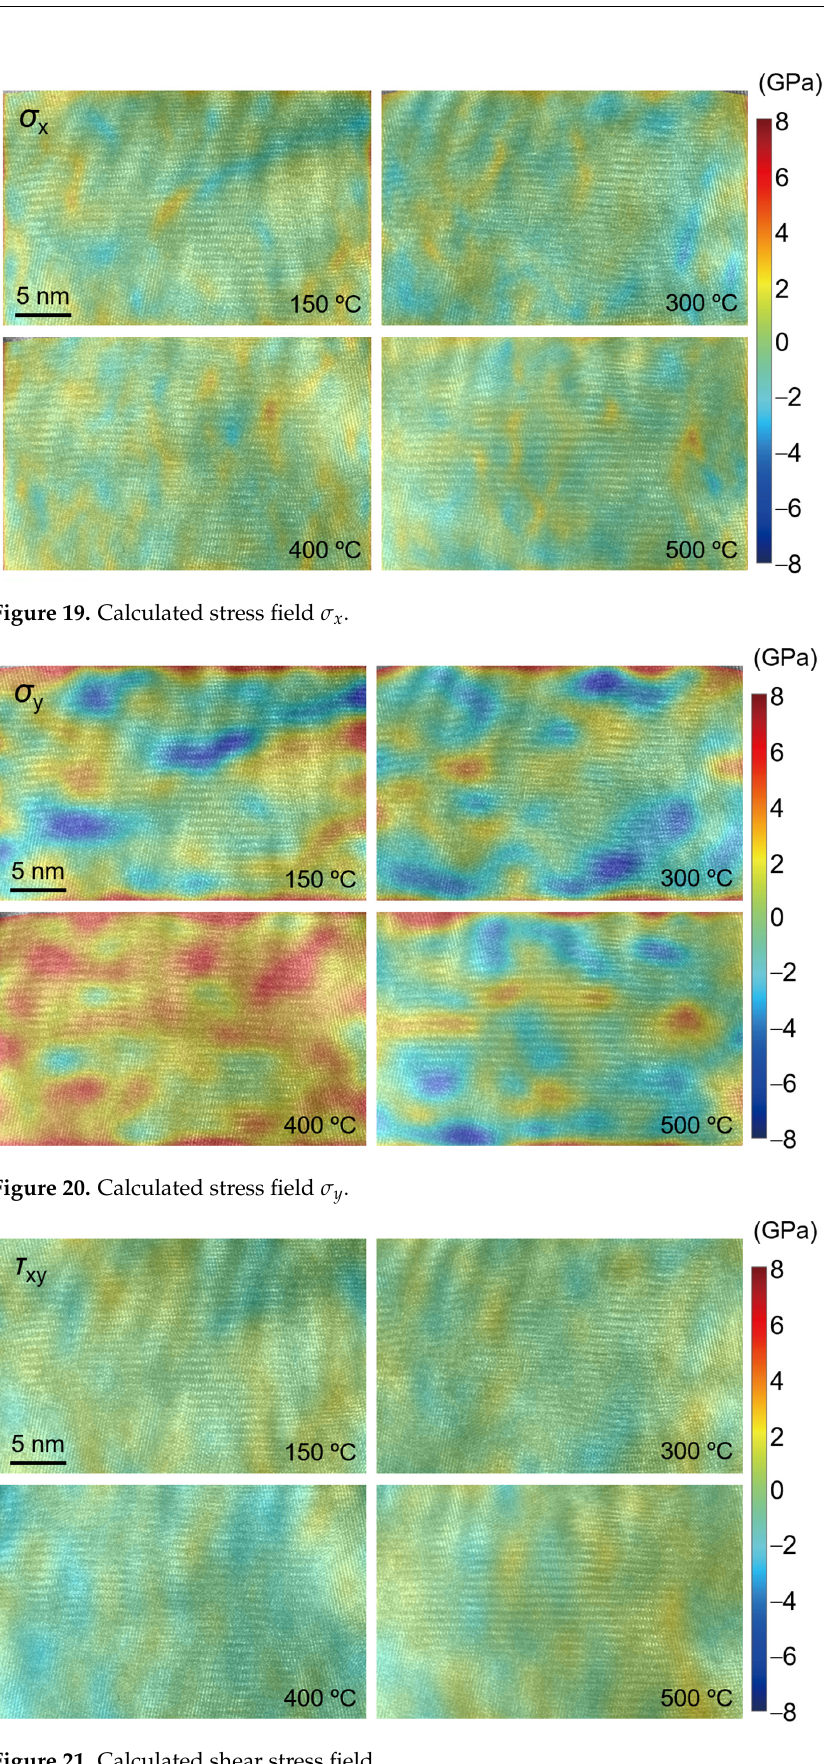
Figure 21. Calculated shear stress field.